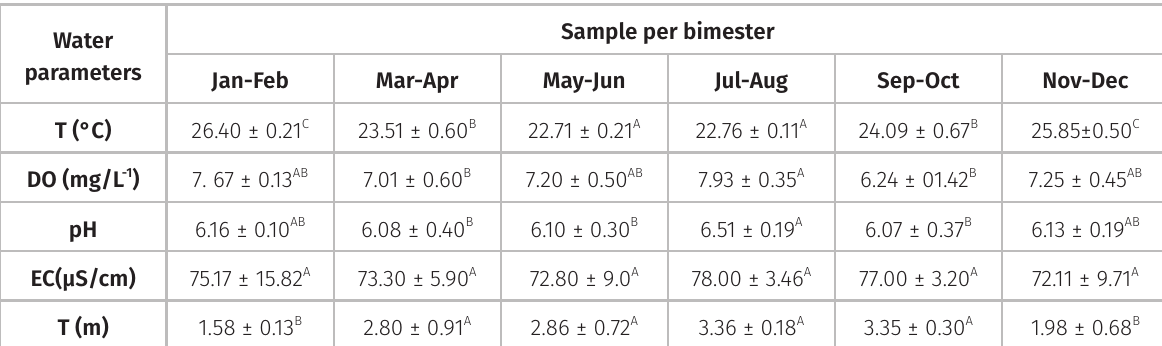
Values represent mean ± standard deviation of 5–8 measurements. Different letters indicate significant differences between the sampling periods, with p <